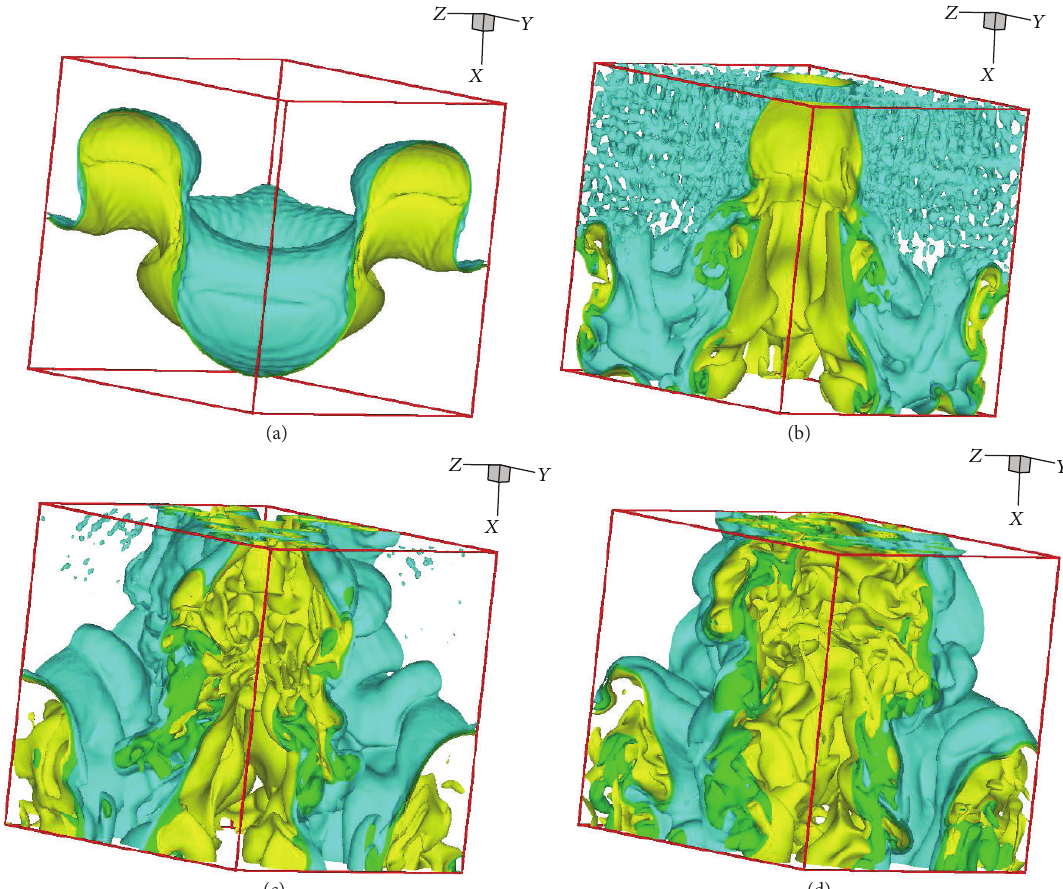
Figure 10: Instantaneous isosurfaces of density ( 𝐶 = 7 and 𝐶 = 9 ) on a subdomain of size 4.5 × 4.5 × 4.5 cm 3 , (a) 𝑡 = 1 ms, (b) 𝑡 = 2 ms, (c) 𝑡 = 3 ms, and (d) 𝑡 = 4